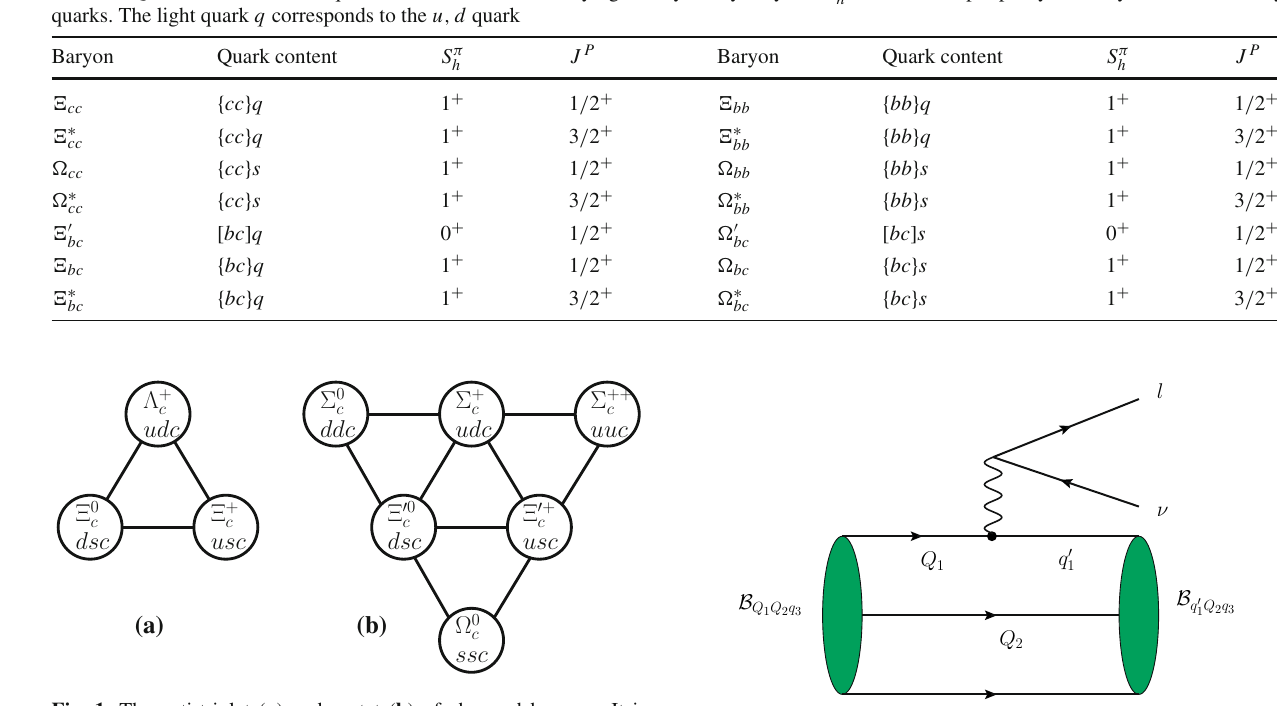
denotes the spin/parity of the system of two heavy h